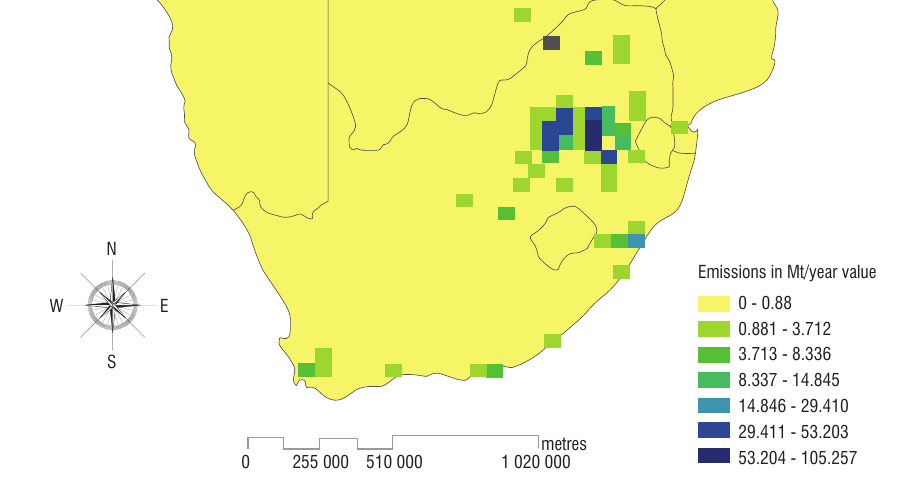
emission point sources in South Africa. 2